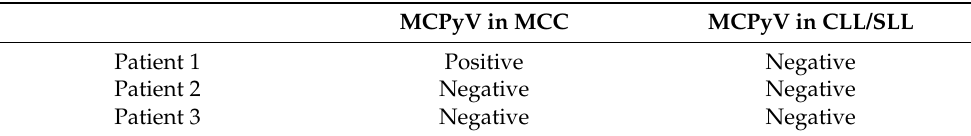
Table 1. MCPyV detection by PCR in adjacent MCC and CLL/SLL from cutaneous or surgical